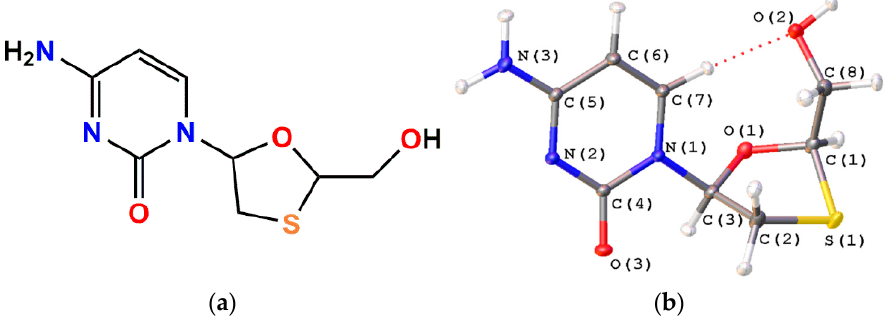
Figure 1. ( a ) Chemical formula of Lamivudine ; and ( b ) its view in atomic displacement ellipsoids (50% probability) in the tetragonal polymorph II after the multipole refinement.